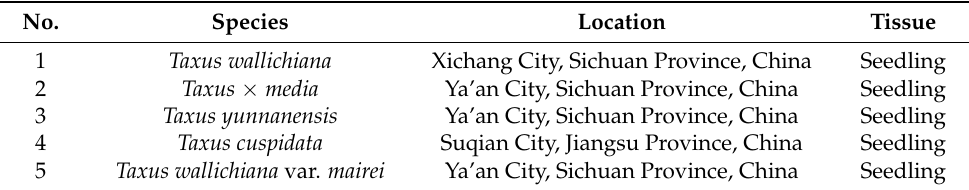
Table 1. Collection of seedling